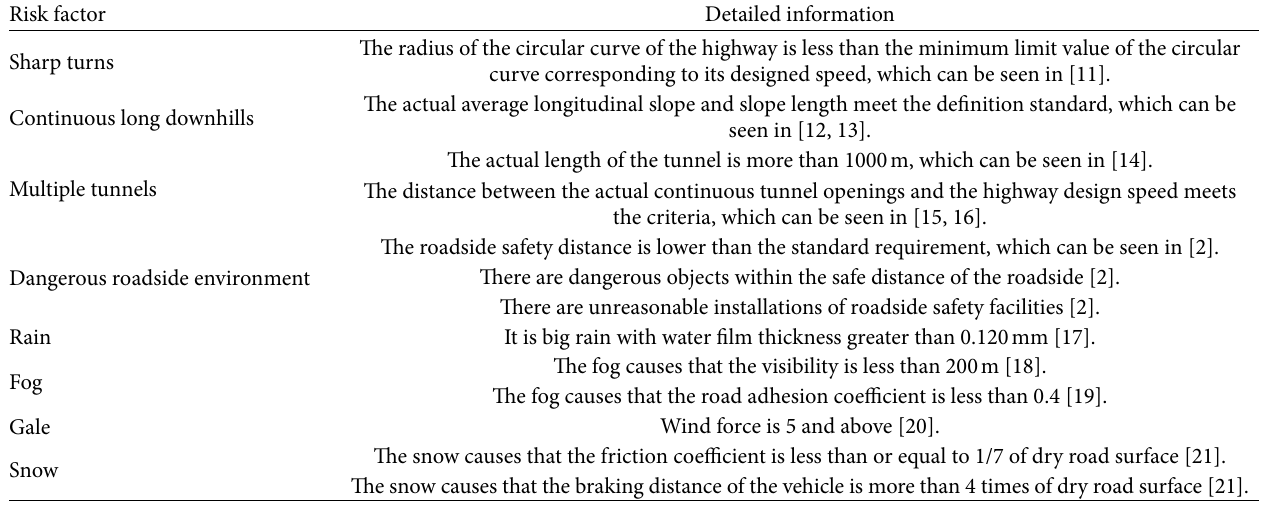
Table 1: Detailed information of the 8 risk